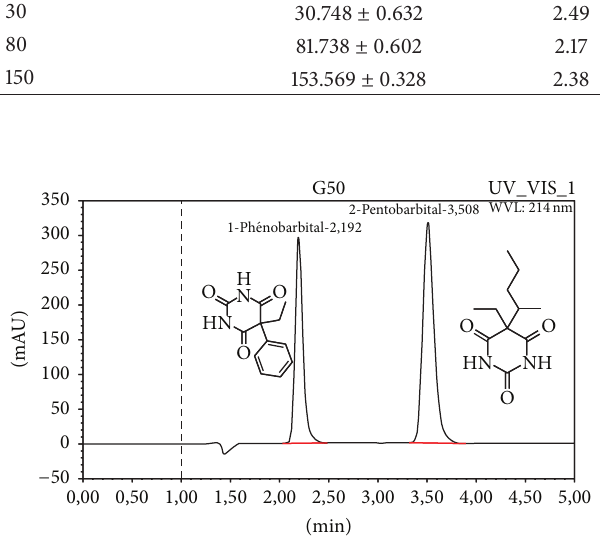
Figure 1: Typical chromatogram of pentobarbital sodium and inter- nal standard and their chemical structures.